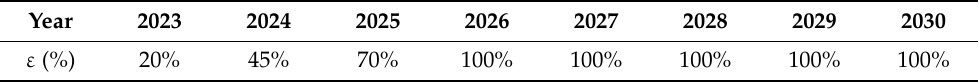
Table 3. Penalty allowance until 2026 as predicted by the Carbon Border Adjustment